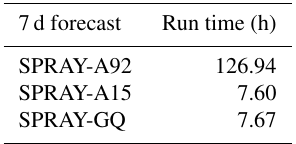
Table 1. The run time of the coupled Climate Forecast System model version 2.0 (CFSv2.0) and WAVEWATCH III (WW3) sys- tem’s global experiments for 7d forecast with different parameteri-